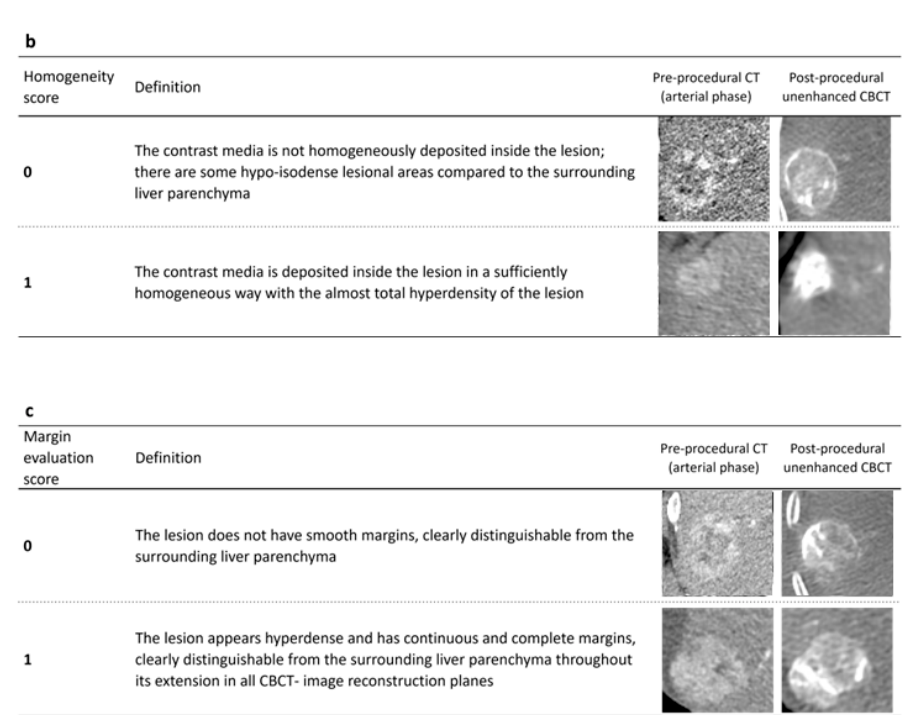
Figure 1. Subjective score visually assigned by the two radiologists for intensity ( a ), homogeneity ( b ), and margins ( c ) of contrast media deposit in unenhanced post-interventional CBCT.